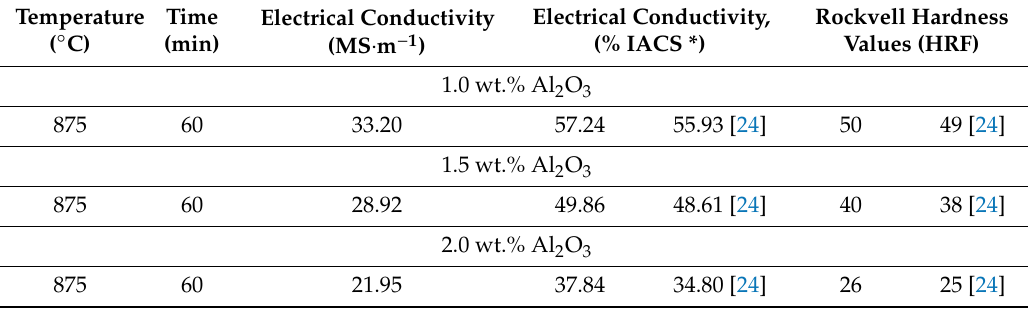
Table 1. Comparison of the electrical conductivity and hardness values (HRF) after sintering at 875 °C and 60 min in our work with values of Amirjan [24].